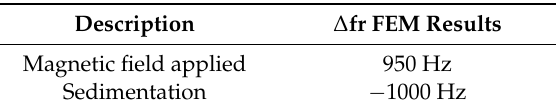
Table 2. Resonant frequency shifts of the quartz resonator calculated for settling and external magnetic field conditions (Note: the changes are referenced to the case of carrier fluid placed on the